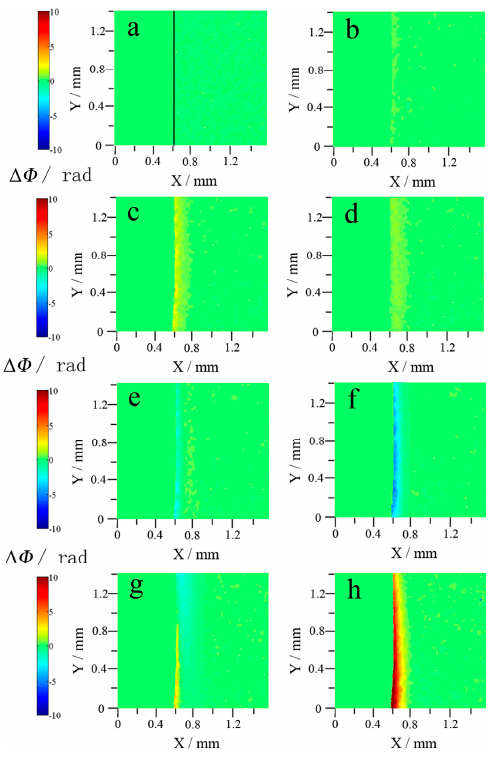
Figure 4. The phase distributions at different times in Figure 3a during potentiodynamic polarization of copper in 0.5 M NaCl solution. ( a–h ) are corresponding to the points a–h in Figure 3a.